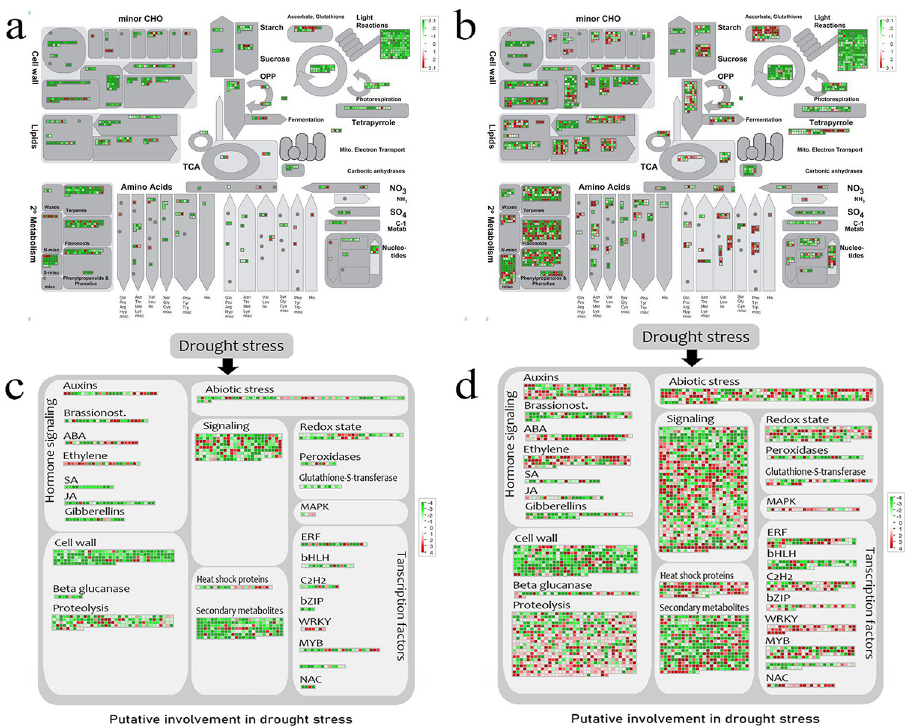
Fig 7. MapMan visualization of drought stress-responsive DEGs in DS and DT under drought stress. Each square represents a gene, red means up-regulated, green means down-regulated. (a)Metabolism overviews of DS at 14-days of drought stress. (b) Metabolism overviews of DT at 14-days of drought stress. (c) Abiotic stress metabolism pathway of DS after 14-days of drought-stress. (d) Abiotic stress metabolism pathway of DT after 14-days of